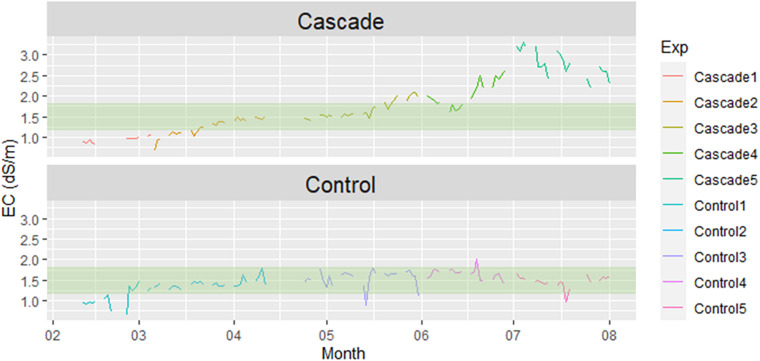
Electrical conductivity (EC). Highlighted area represents the suitable EC range to grow hydroponic lettuce stated by Singh and Dunn (2016).